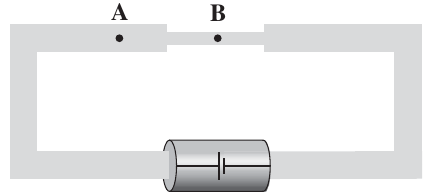
FIG. 5. A simple circuit with a “ resistor ” (a thin section of the wire).